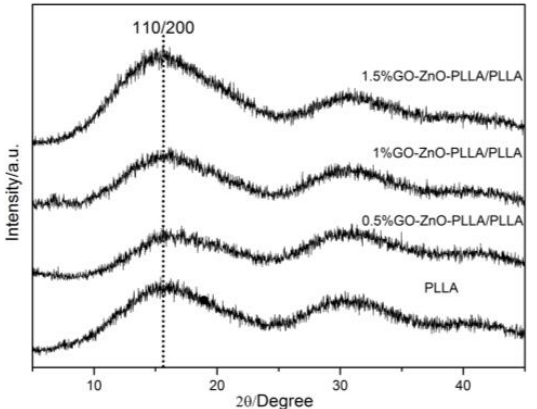
Figure 12. The XRD patterns of pure poly(lactic acid) film and its GO-ZnO-PLLA/PLLA composite film. 3.12. Test of the Antibacterial Properties of GO-ZnO-PLLA/PLLA Composite